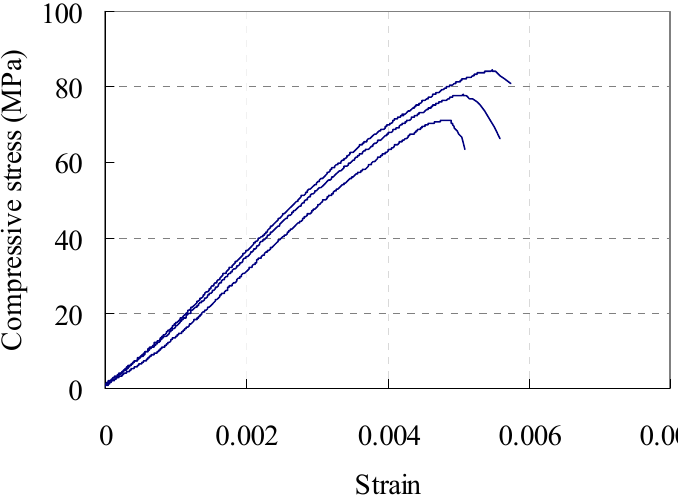
Figure 1. Stress–strain behavior of high-performance fiber-reinforced cementitious composite (HPFRCC) in uniaxial